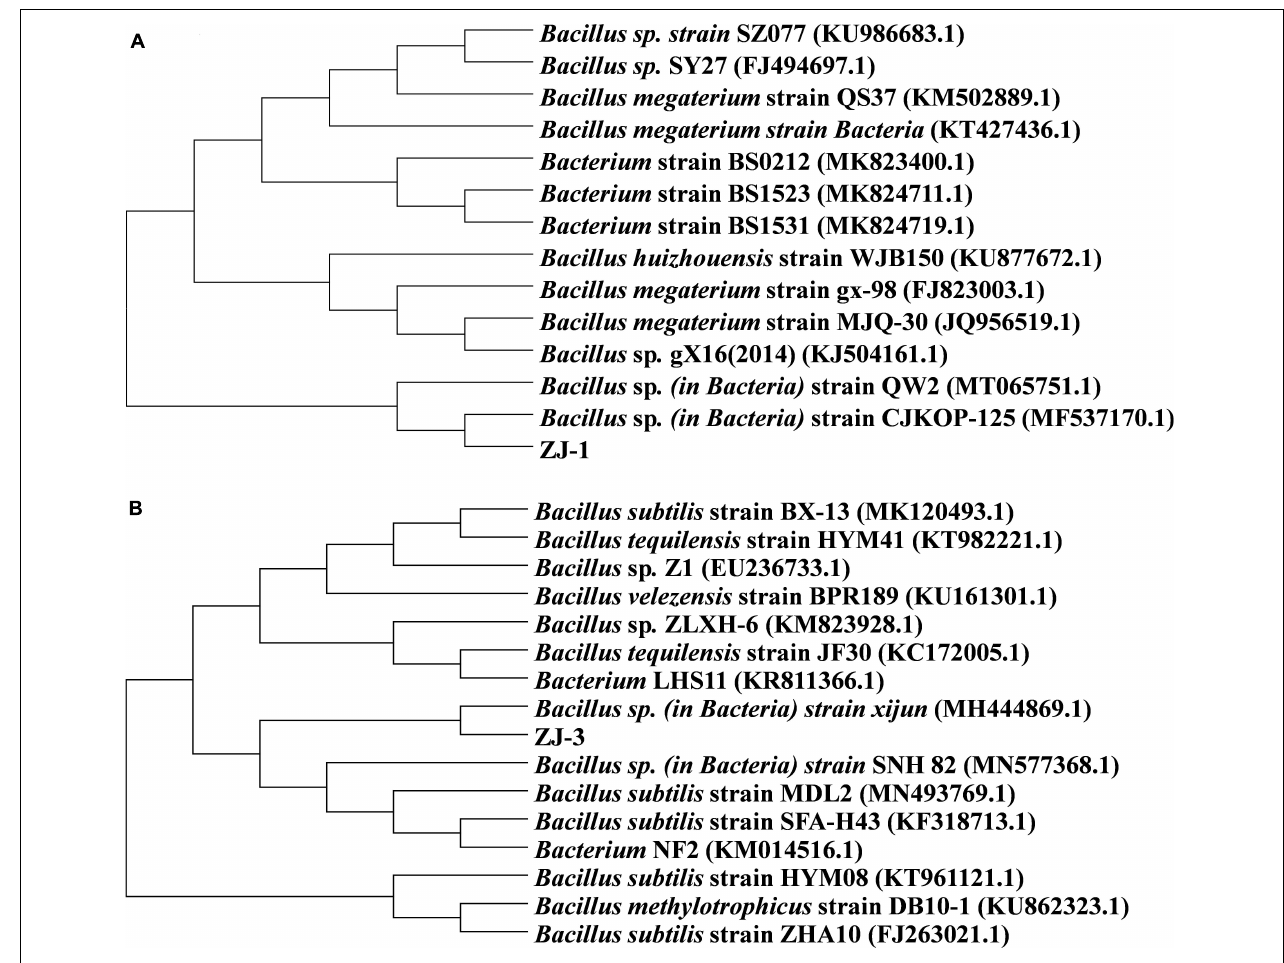
FIGURE 1 | Phylogenetic tree based on 16S rRNA gene sequences of isolated (A) ZJ-1, (B) ZJ-3, and closely related